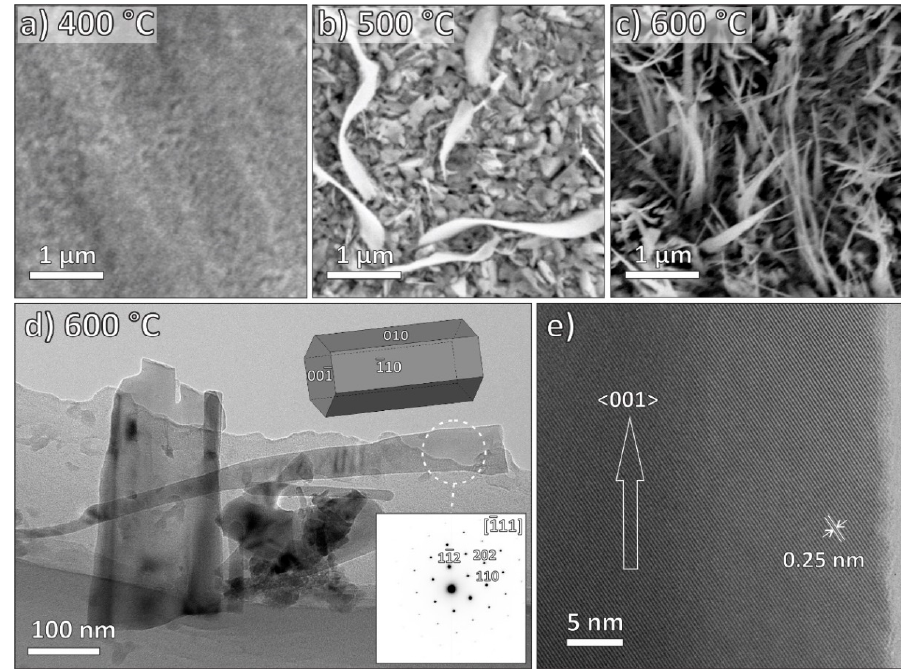
Figure 5. ( a – c ): SEM images of iron oxide nanostructures synthesized at different growth temperatures: ( a ) 400 °C, ( b ) 500 °C, and ( c ) 600 °C, respectively; time period of growth was 30 min. ( d ) TEM micrograph of a single-crystalline α -Fe 2 O 3 nanostructure grown at 600 °C with the corresponding SAED pattern (inset) and a model of crystal in the corresponding orientation. ( e ) High-resolution TEM micrograph of an α -Fe 2 O 3 nanostructure, with the marked interplanar spacing of 0.25 nm. The nanostructure is elongated in the <001> direction.